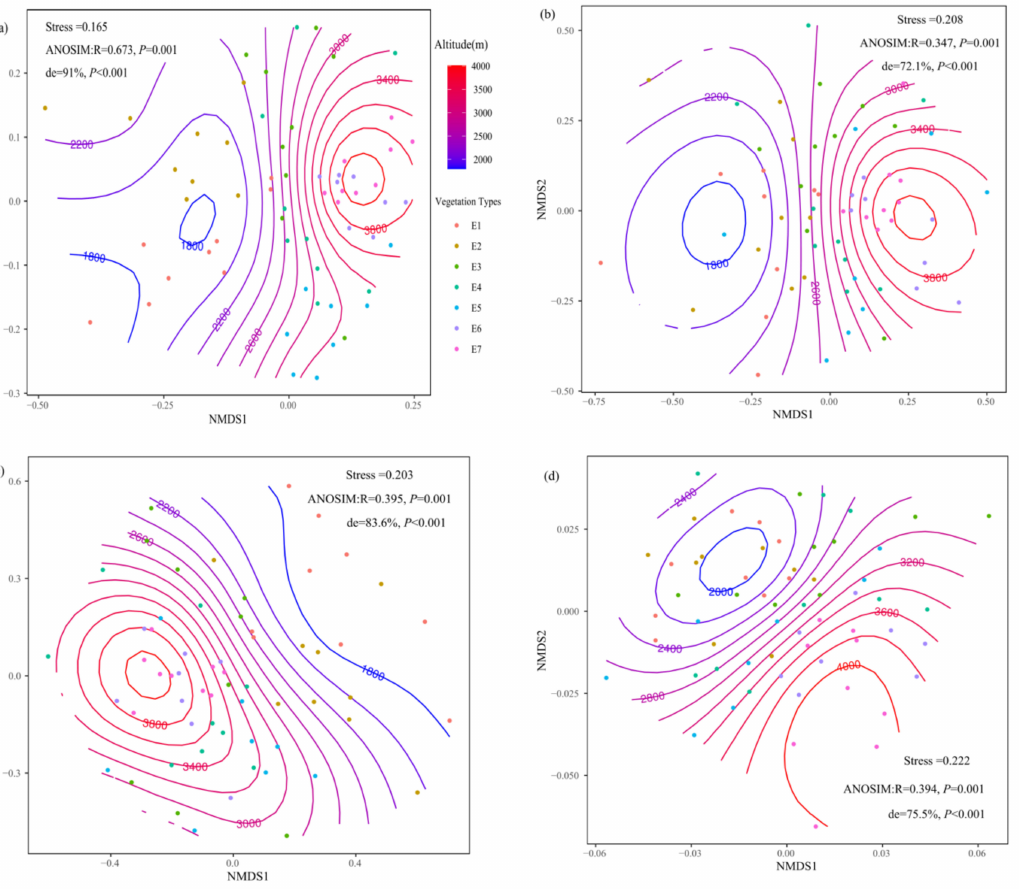
Figure 3. Non-metric multidimensional scaling (NMDS) and analysis of similarities (ANOSIM) rep- resent community compositional dissimilarity of soil total fungi ( a ), symbiotic fungi ( b ), saprophytic fungi ( c ), and pathogenic fungi ( d ) among different altitude gradients. ‘de’ shows the deviance explained by the generalized additive